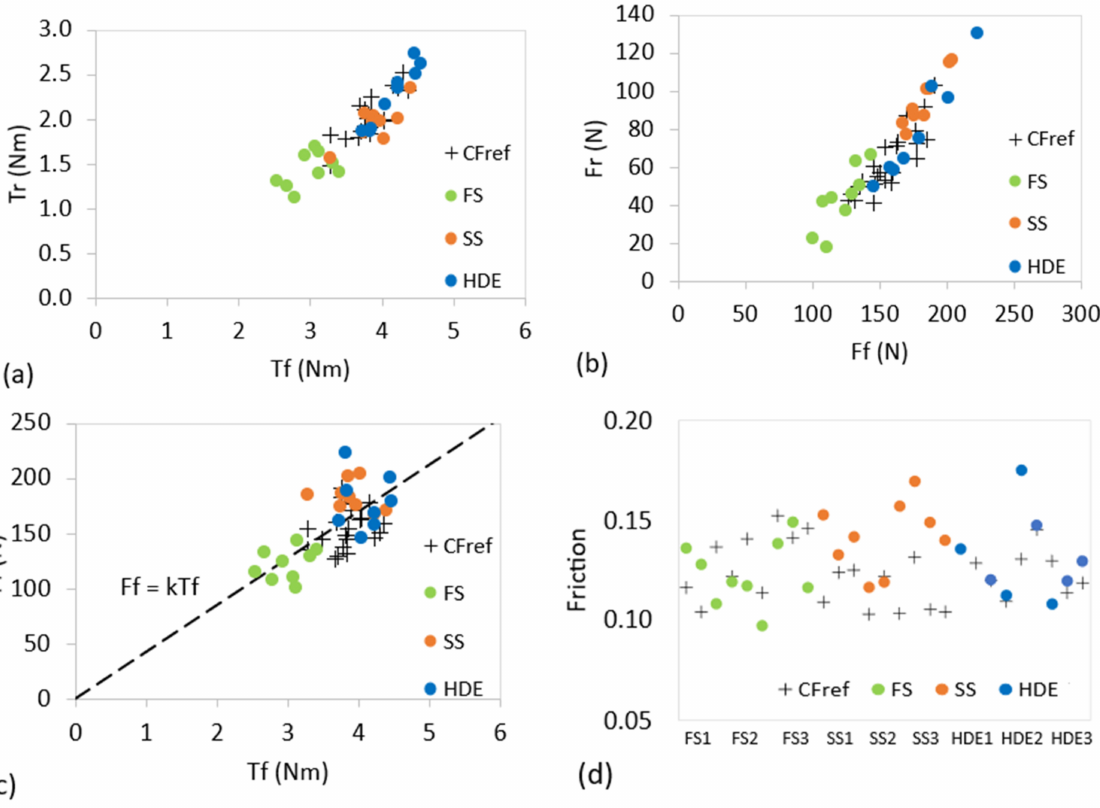
Figure 9. Relationship between performance measures in soft synchronous tapping ( a – c ), and friction between the tool cutting edge rake face and chip ( d